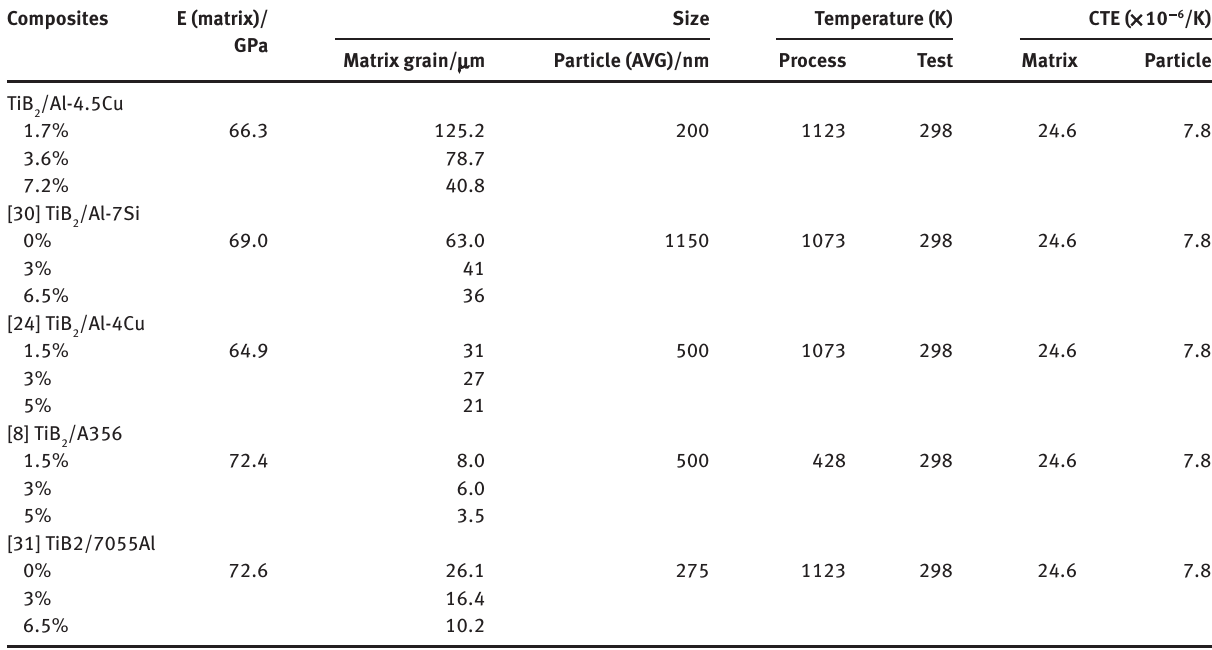
particles reinforcing Al matrix composites. 2